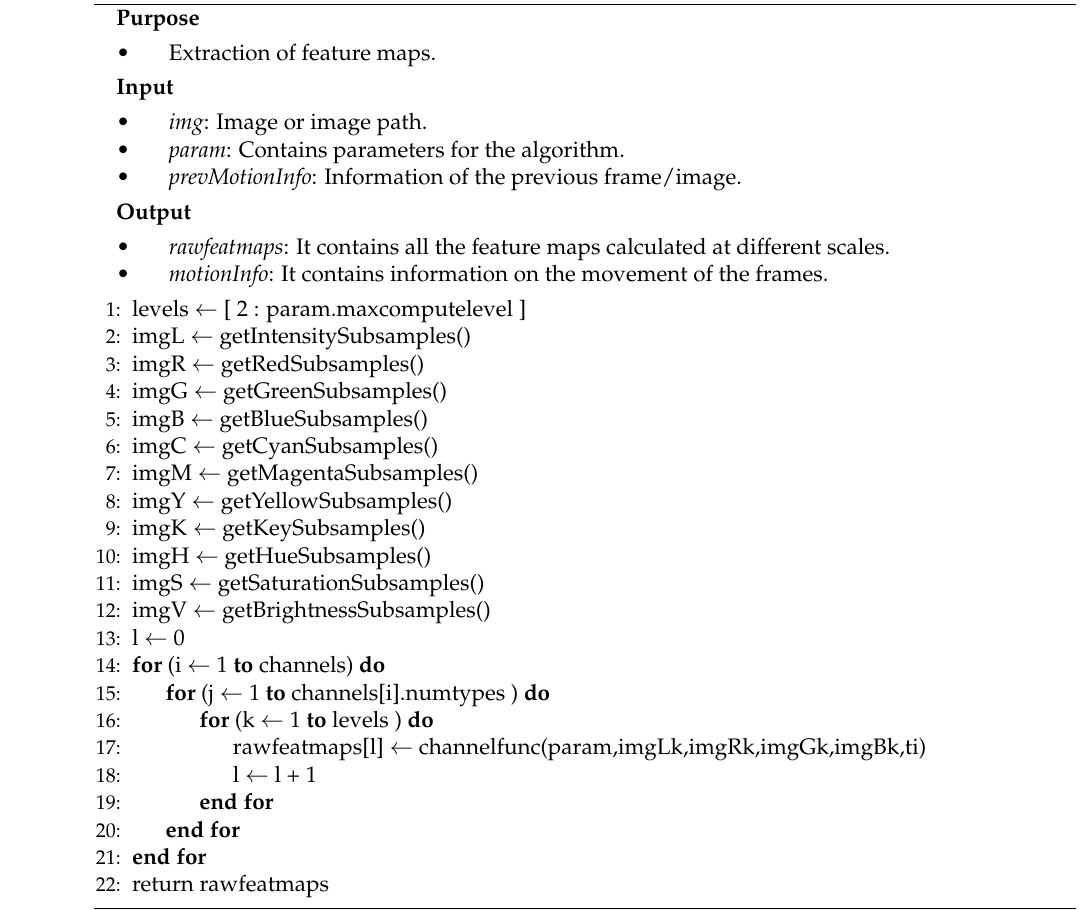
Algorithm A6 getFeatureMaps